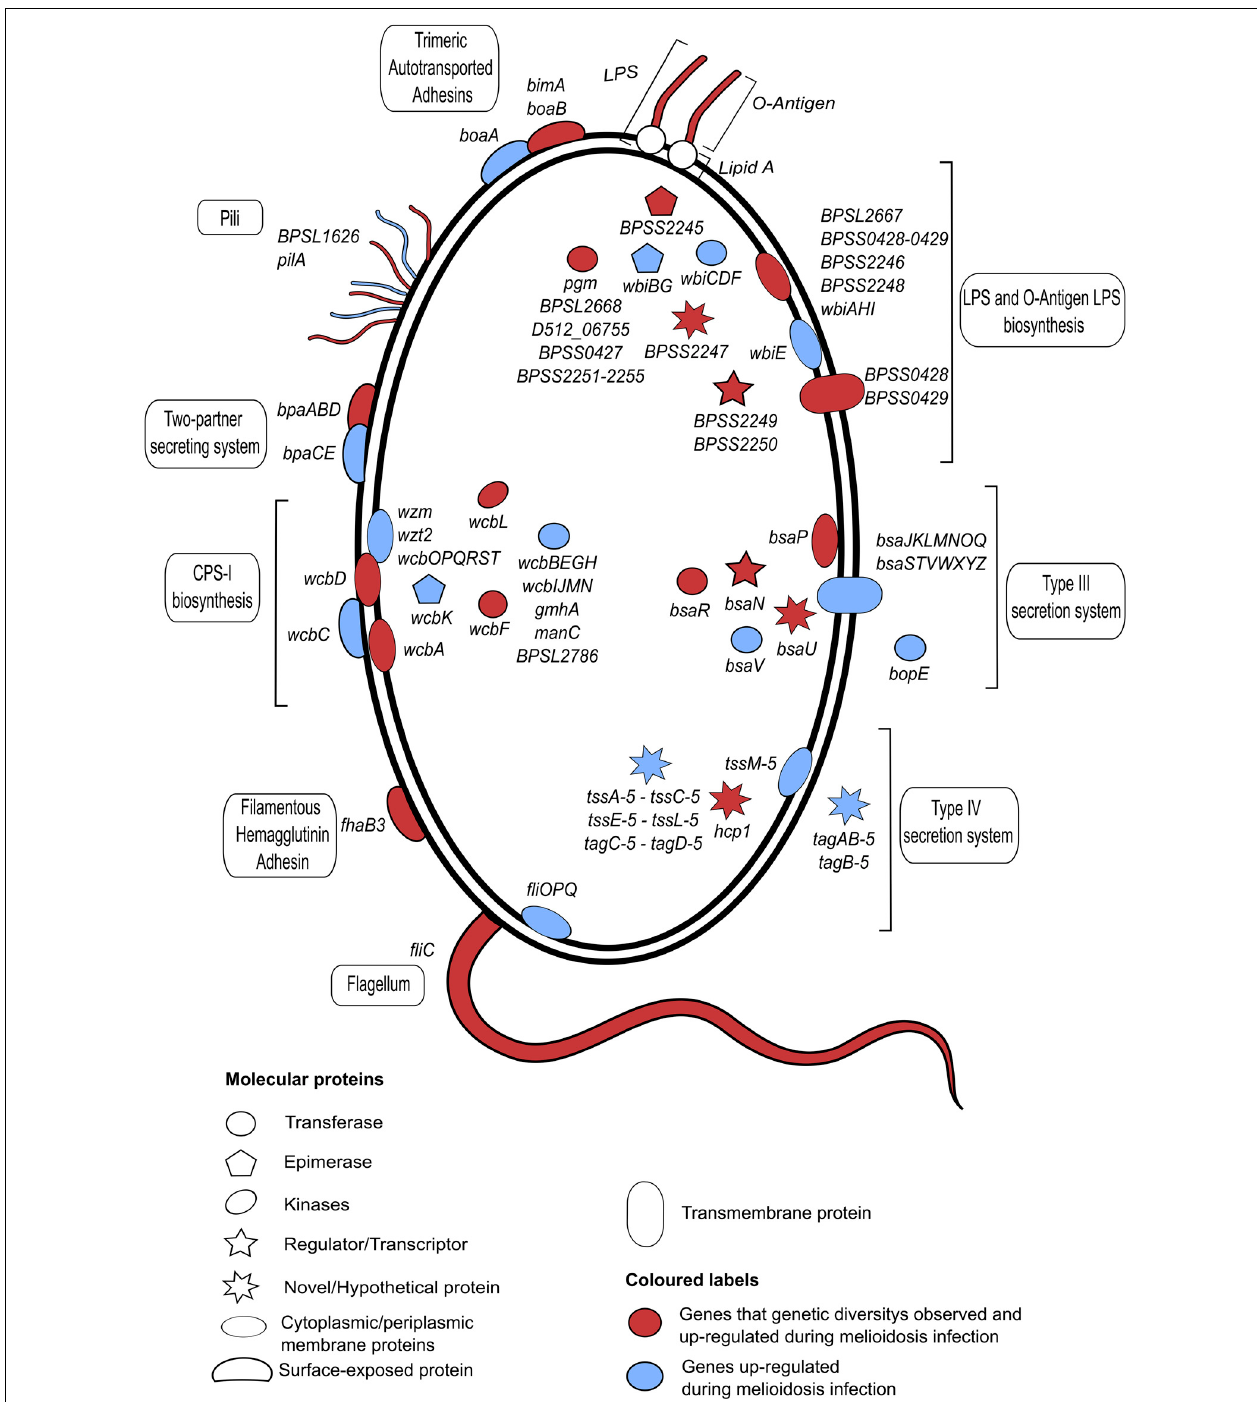
FIGURE 2 | A summary of B. pseudomallei genes or operons that are expressed during infection and characterized genetic variations. All plotted genes or operons are up-regulated during in vivo infections (Ooi et al., 2013), with a subset that reported genetic variations marked in red. The shape and location of each individual gene indicate the gene function and cellular compartment, respectively. All annotated genes or operons and their functions are described. The bacterium displays a repertoire of antigenic variations, including lipopolysaccharides (LPS), capsular polysaccharides (CPS) and surface proteins. B. pseudomallei LPS is immunologically classified into a number of serotypes A, B, and B2; with each serotype reported to be heterogeneously distributed across distinct geographical locations. Another highly diverse virulent protein is a fimbrial protein which displays a strong geographical distribution between Australia and Asia. Strains from Asia commonly possess a Yersinia -like fimbrial (YLF) gene cluster that believed to be horizontally acquired. B. pseudomallei carries 4 different types of CPS: CPS I, CPS II, CPS III, and CPS IV. A full gene description is provided in Supplementary Table 1 .